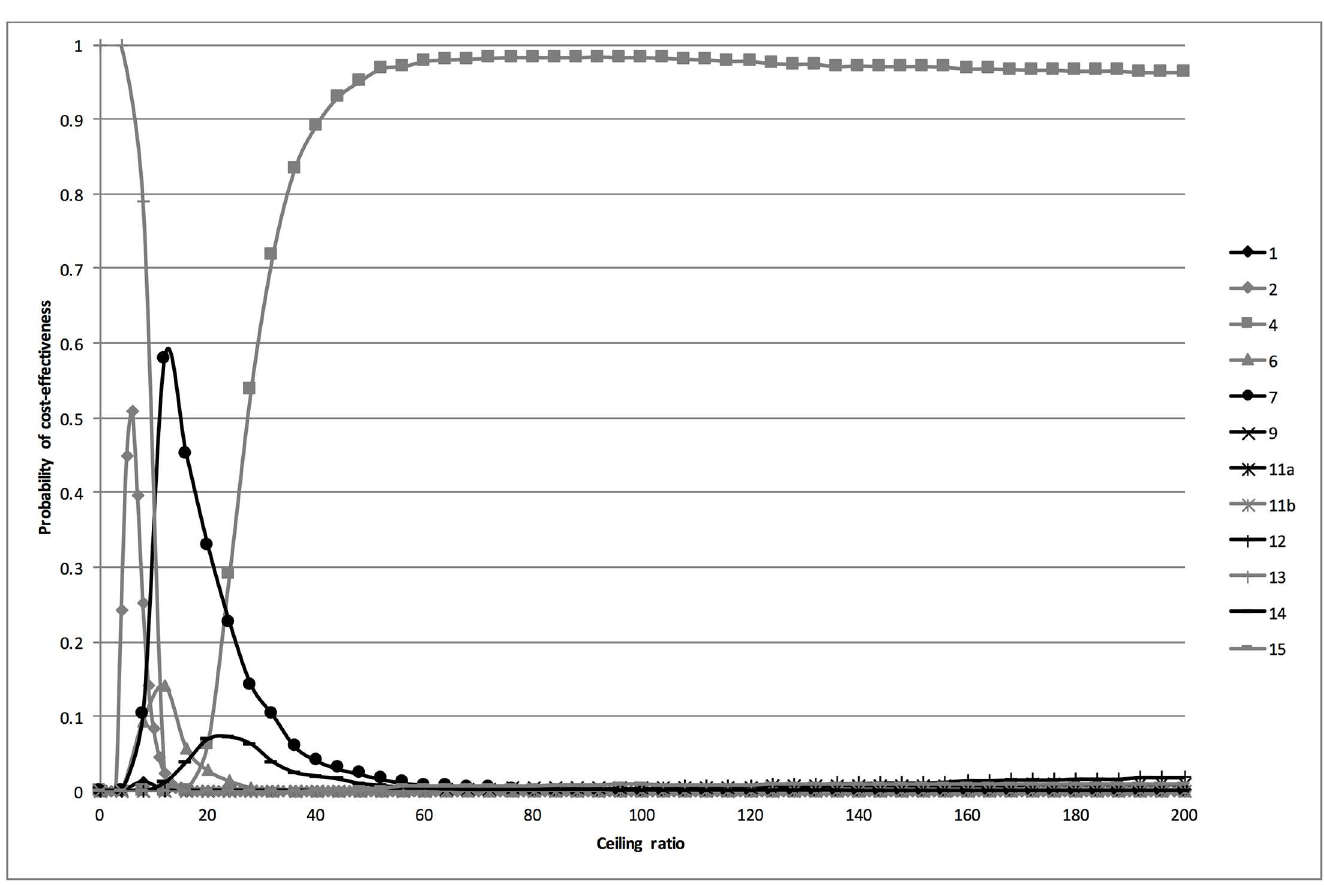
Fig 4. Cost-effectivenessacceptability curves for the analysis excluding the sediment. The cost-effectiveness acceptability curves are based on the probabilisticanalysis. They show the probabilitythat the different diagnostic strategies are cost-effective at a range of ceilingratios.